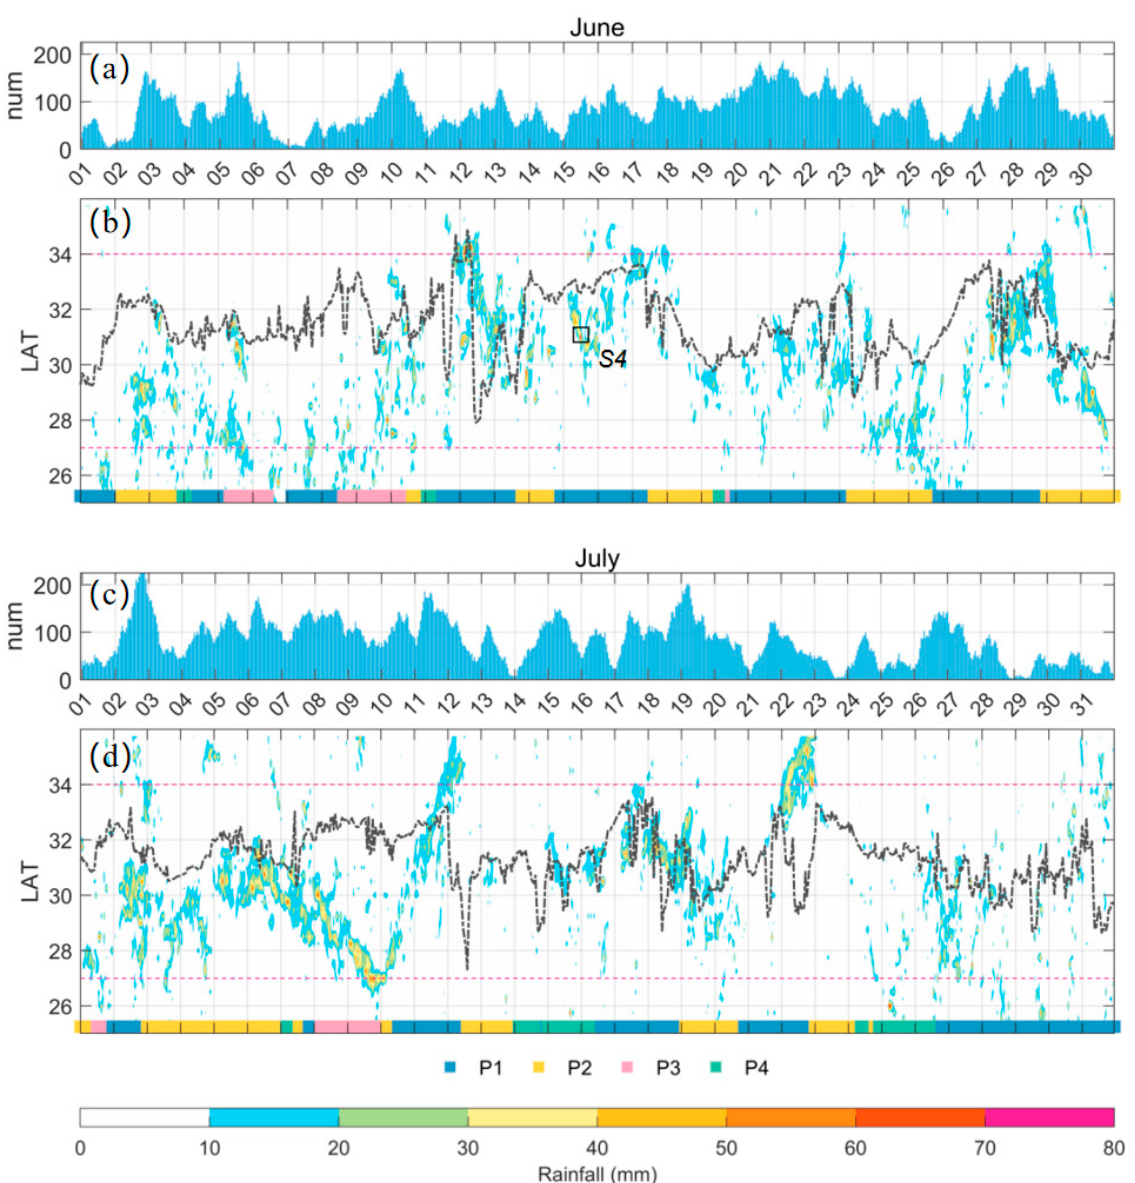
Figure 8. The time series of rainfall clusters under the four synoptic patterns during June–July 2020. ( a , c ) are the time series of the hourly rainfall frequency recorded by rain gauge stations over the YHRB in June and July 2020, respectively. ( b , d ) are Hovmöller (latitude–time) plots of hourly rainfalls (mm) averaged within 111–122 ◦ E. The black dashed lines denote the distribution of the Meiyu front at hourly intervals, defined by the maximum gradient of the equivalent potential temperature at 850 hPa. The horizontal red dotted lines denote the latitudinal boundaries of our study area (27–34 ◦ N). The colored blocks at the bottom frame of ( b , d ) denote the synoptic patterns (P1 is in blue, P2 is in yellow, P3 is in pink, and P4 is in green) at hourly intervals. The time and latitude of the maximum hourly rain rates (S4) and maximum hour rain rates for June–July 2020, recorded by national rain gauges, are marked by black squares.